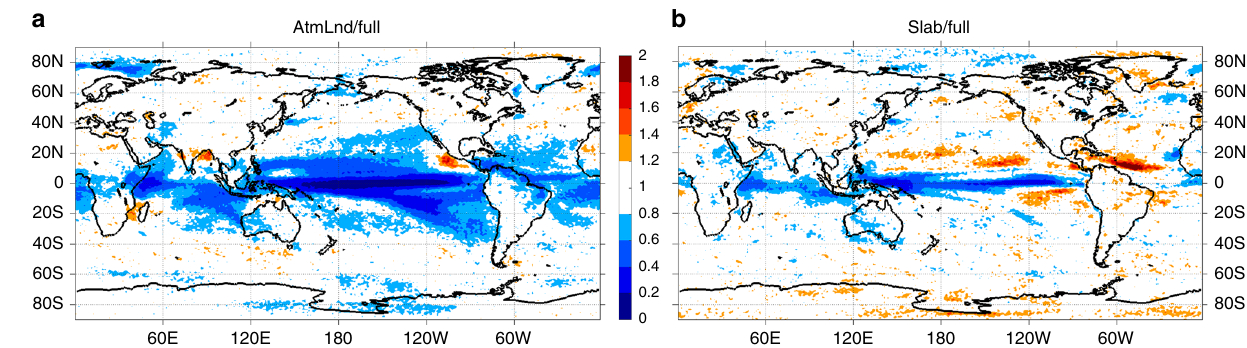
Fig. 5 Ratio of annual precipitation low-frequency internal variability among the CESM1 preindustrial control simulations. a atmosphere/land-only vs fully coupled simulation and b atmosphere/land/slab ocean vs fully coupled simulation. The amplitude of precipitation low-frequency internal variability is estimated as the range (i.e., the difference between the maximum and minimum values) of the 5000 samples constructed with the Monte Carlo approach in each control simulation, where each sample represents the synthetic ensemble-mean precipitation change arising entirely from internal climate variability (see Methods for